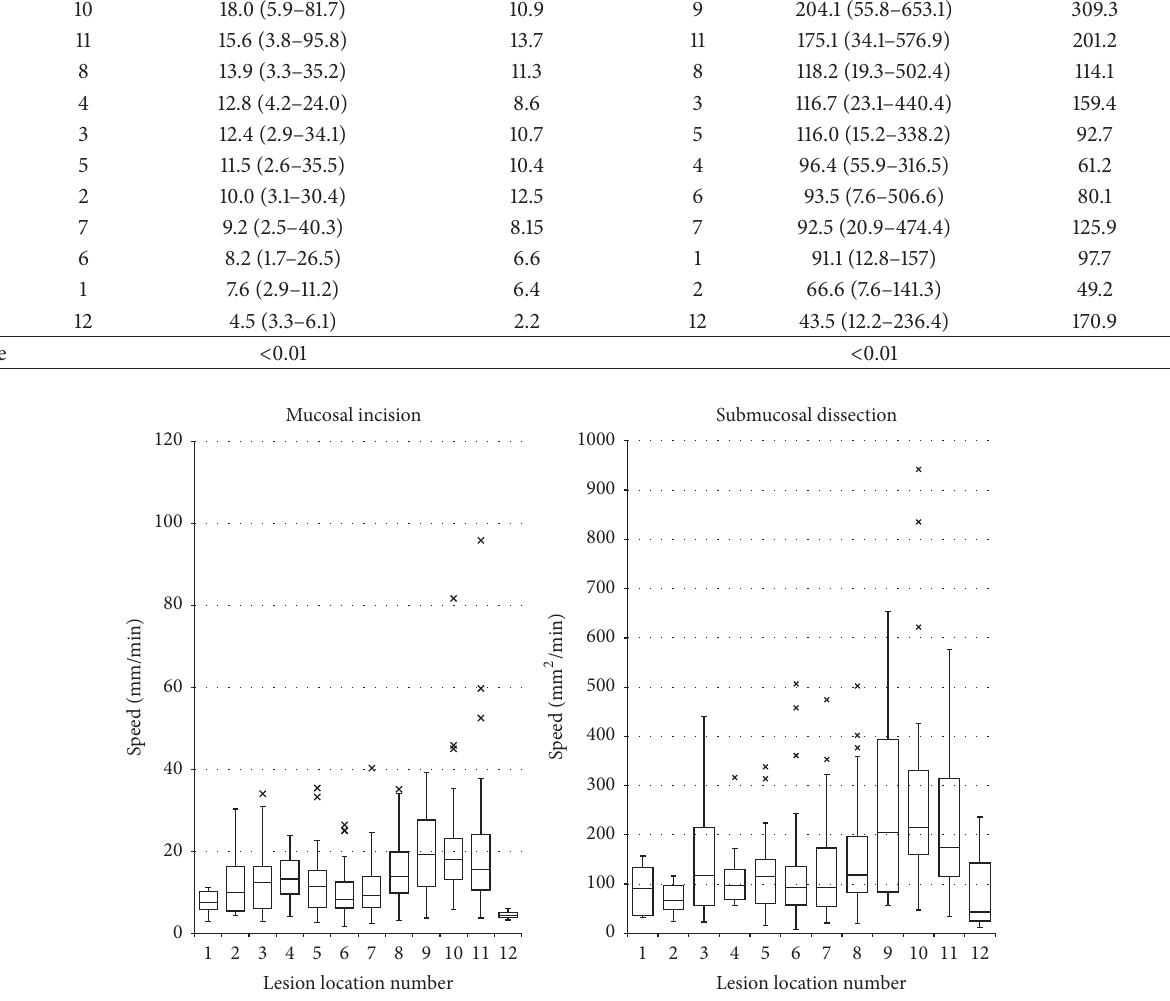
Figure 4: Interquartile range of the mucosal incision and submucosal dissection speed. This figure shows a graph of the mucosal incision and submucosal dissection speed of each of the 12 locations. By noting the interquartile range, the variation in the rate was